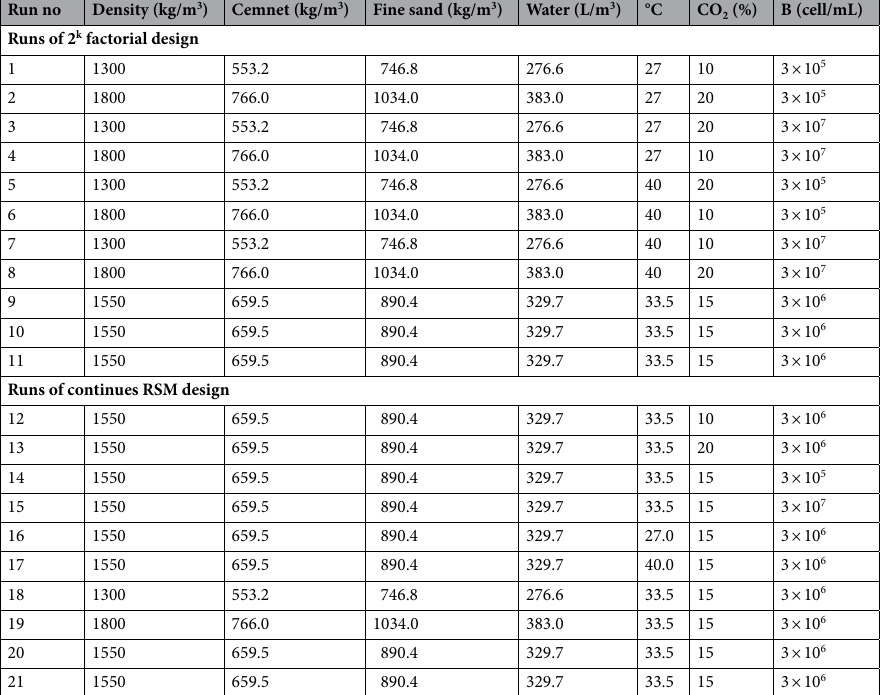
Table 1. The mixture design and factor levels in each run according to 2 k factorial and RSM design. °C temperature, CO 2 concentration of CO 2 , B B. tequilensis concentration.